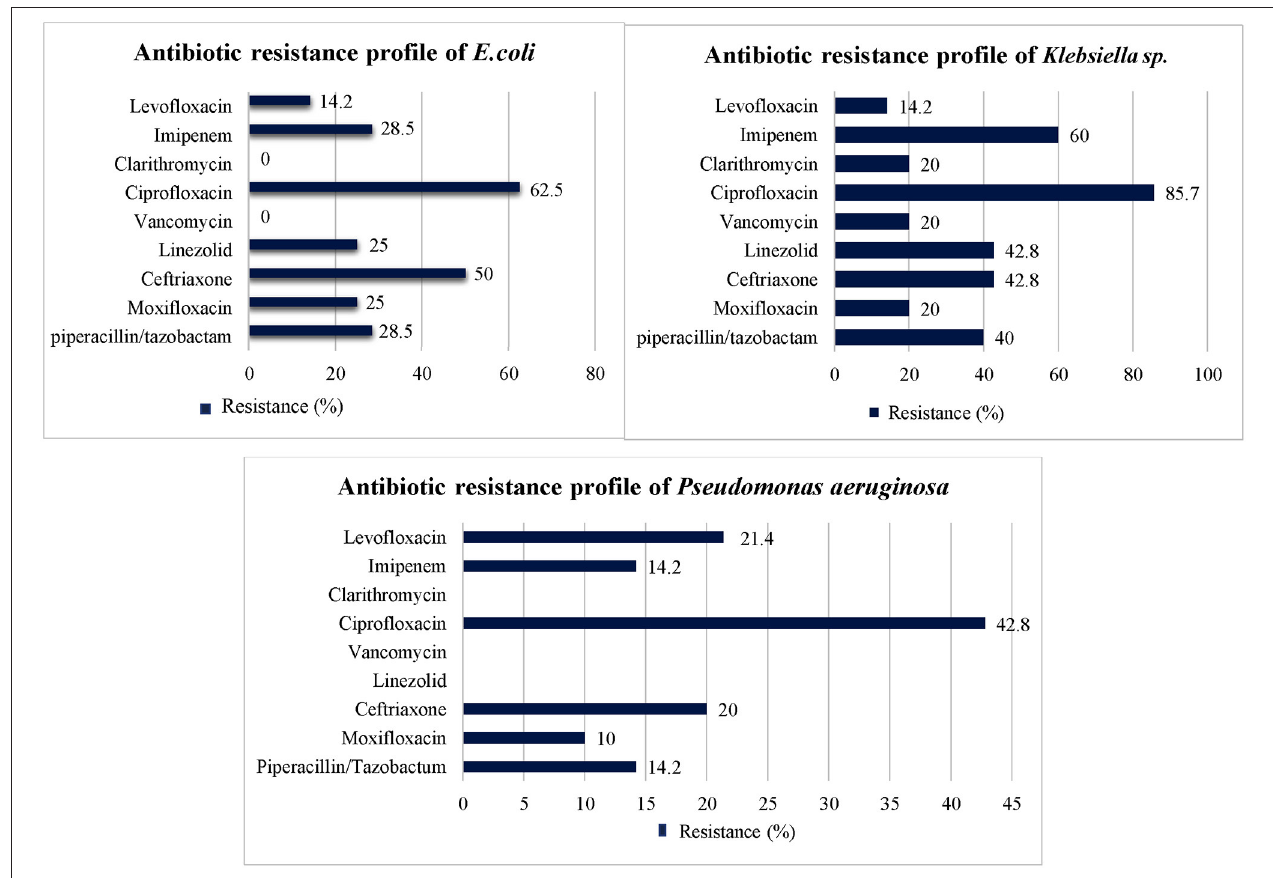
FIGURE 3 | Antibiotic resistance profile of three most prevalent bacterial species.